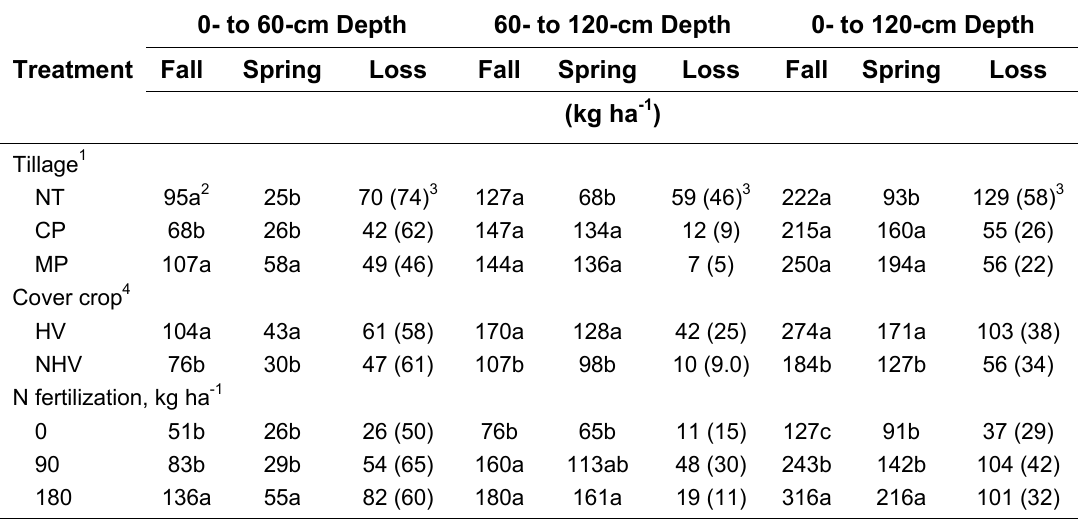
Nitrate-N Content at 0- to 60-, 60- to120-, and 0- to 120-cm Depth in the Fall (September 1997) and the Spring (March 1998) as Influenced by 3 Years of Tillage, Cover